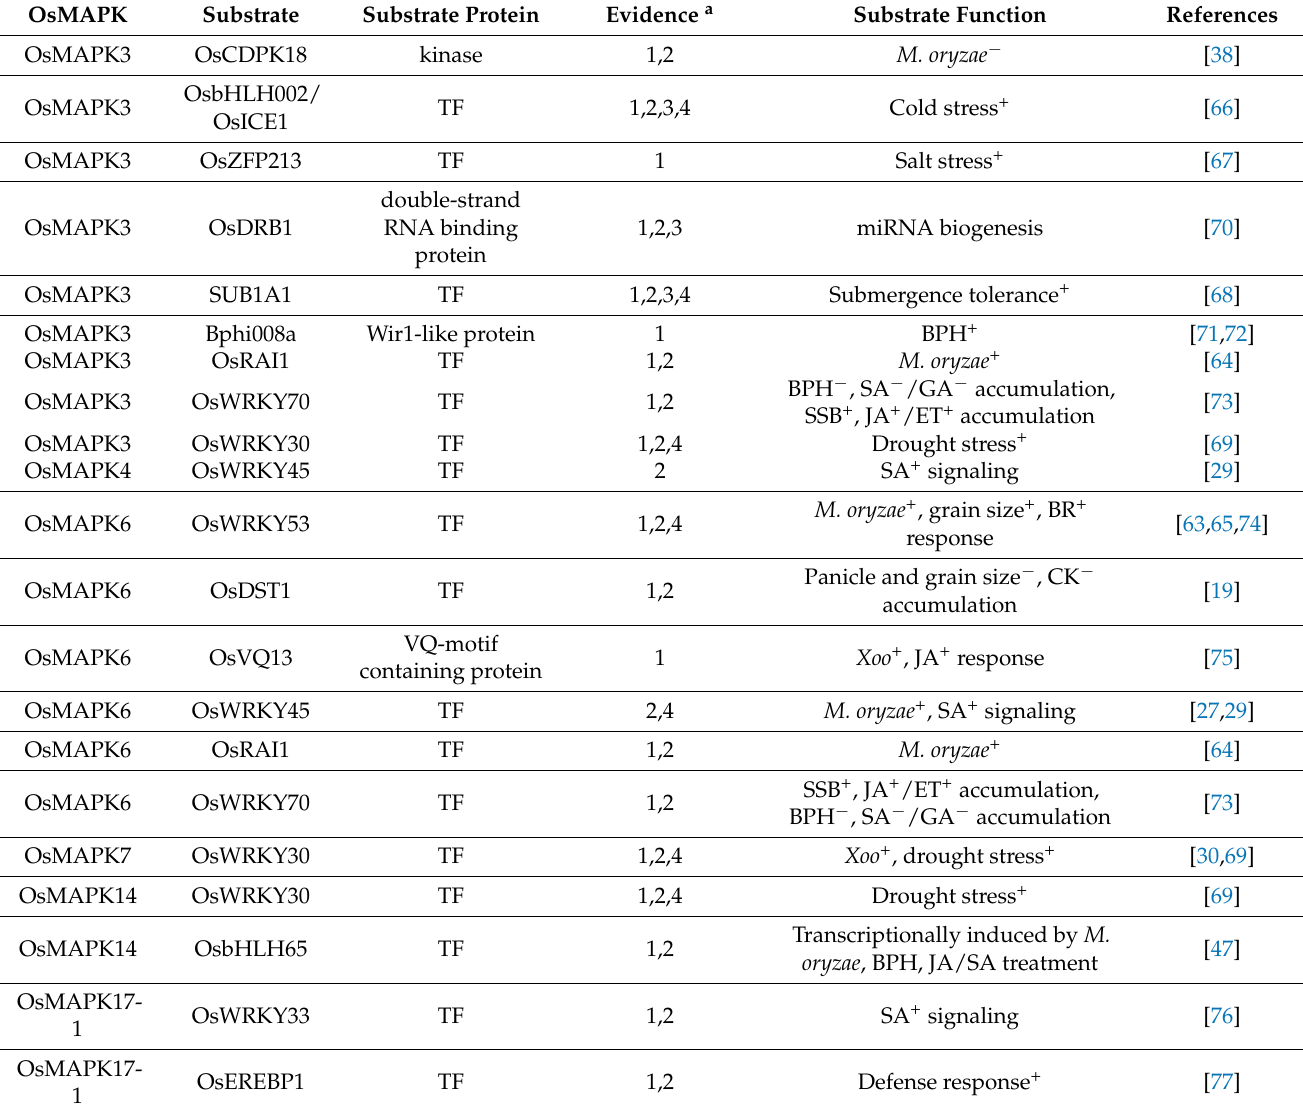
Table 2. Substrates of rice